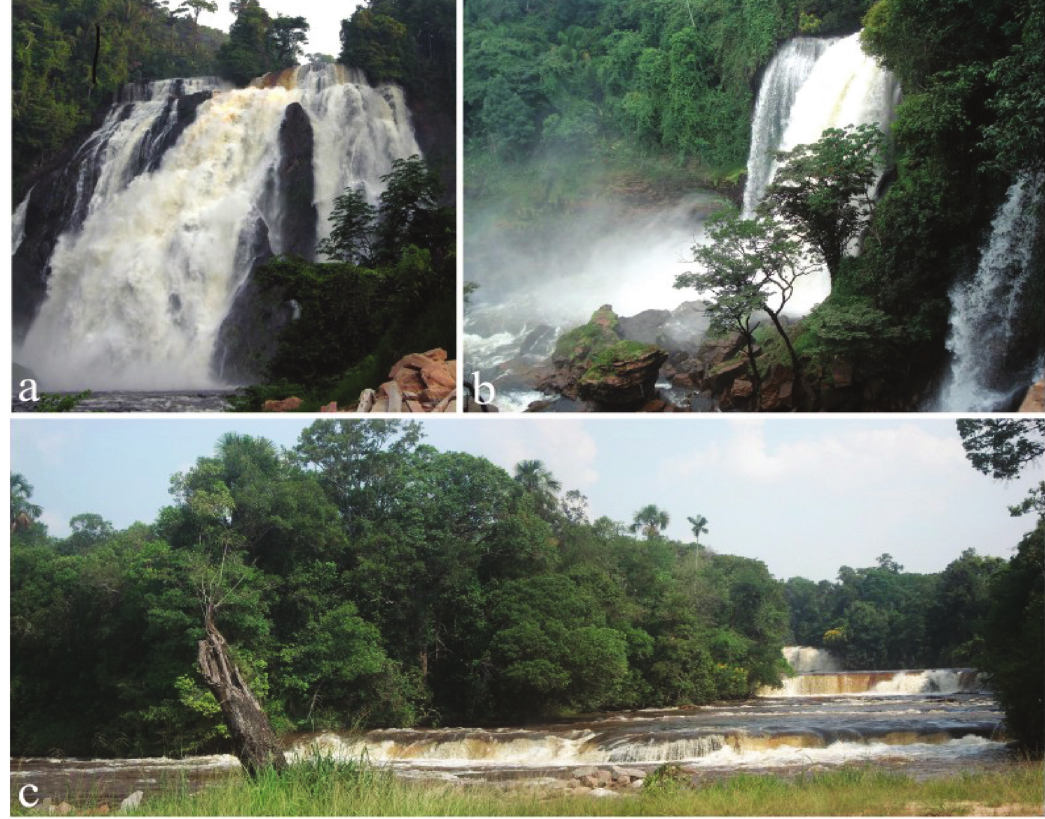
Fig. 6. Waterfall system of rio Curuá: a - 60 meter fall, at 8°43’50”S 54°57’49”W; b - 40 meter fall, at 8°44’09”S, 54°57’46”W; c - three smaller falls of approximately 1 to 5 meters, at 8°46’09”S